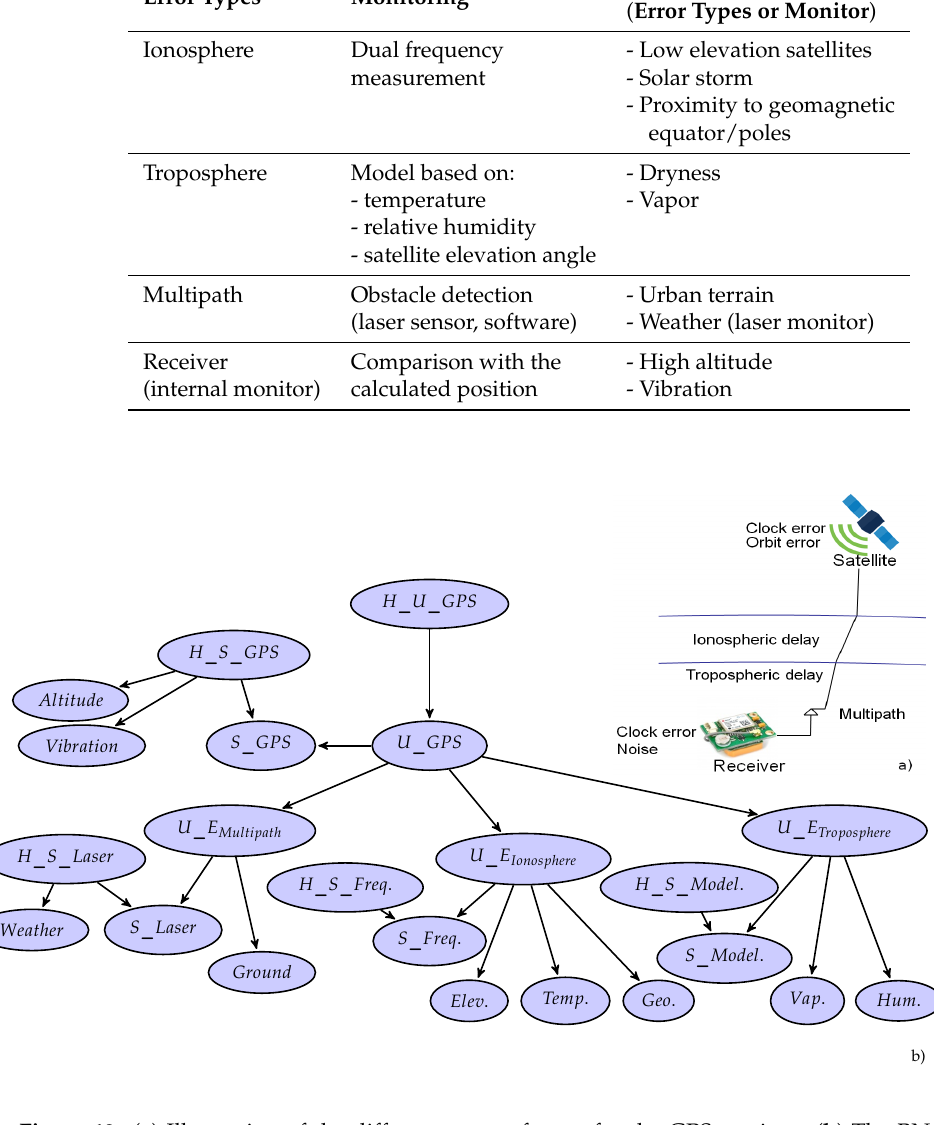
Figure 19. ( a ) Illustration of the different types of error for the GPS receiver. ( b ) The BN monitor generated from the FMEA-like table of Table